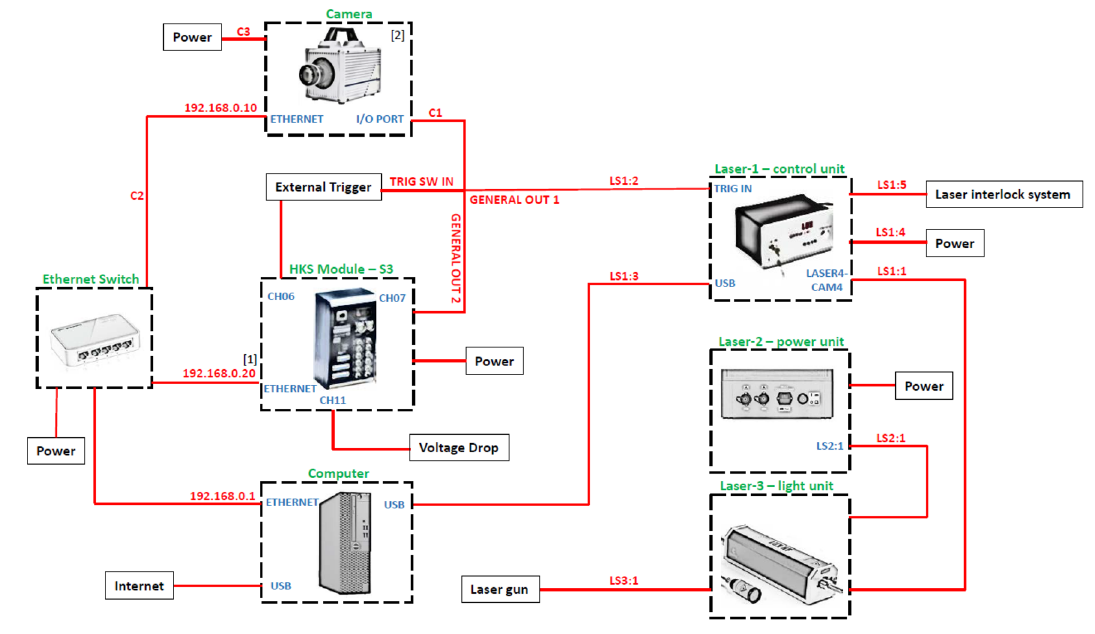
Fig. 3 Schematic setup of HKS weld analyst